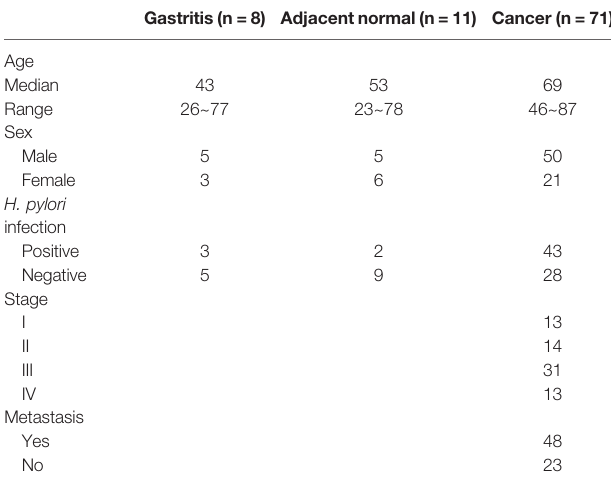
TABLE 1 | Summary of clinico-pathological data of patients ’